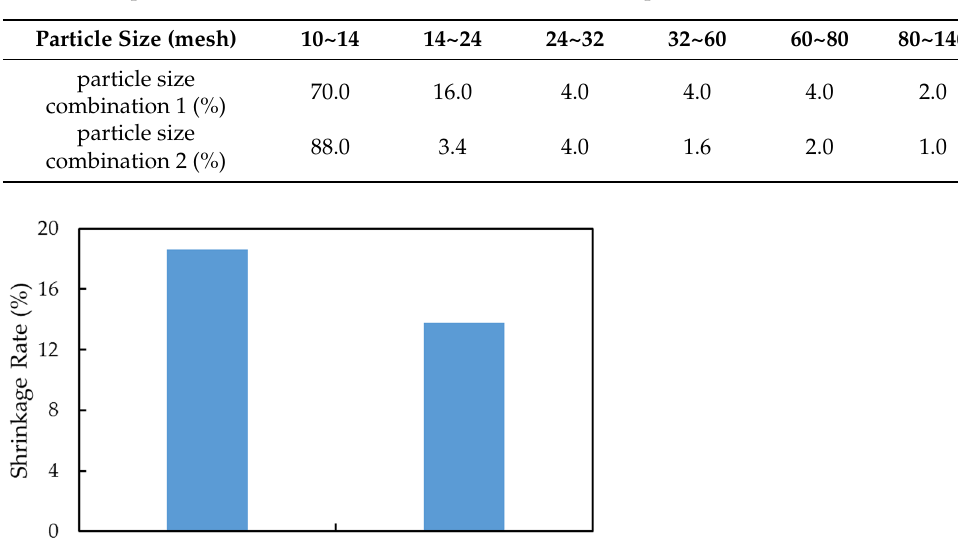
Figure 7. Compact layer formed after injection of PAC30 solution.